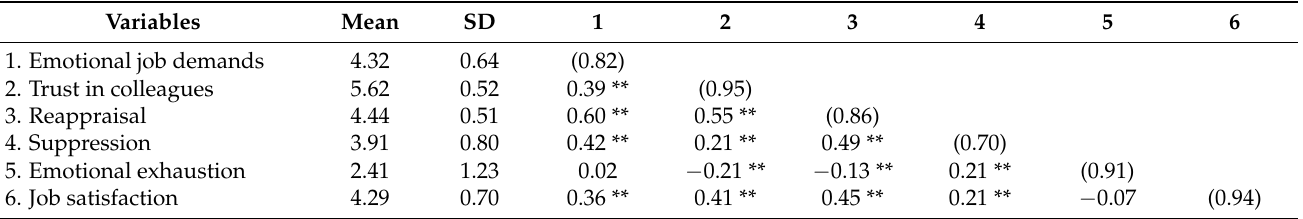
Table 1. Means, standard deviations, bivariate correlations and reliability measures of all of the variables (N =